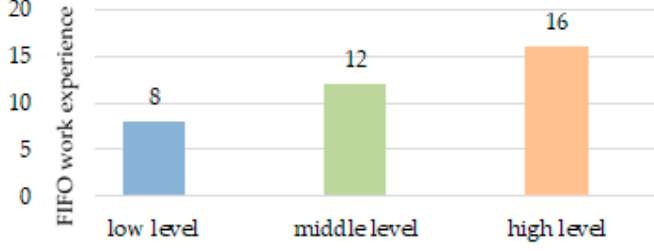
Figure 6. Oil and gas employees’ FIFO work experience with different levels of standard deviation from the autogenous norm.